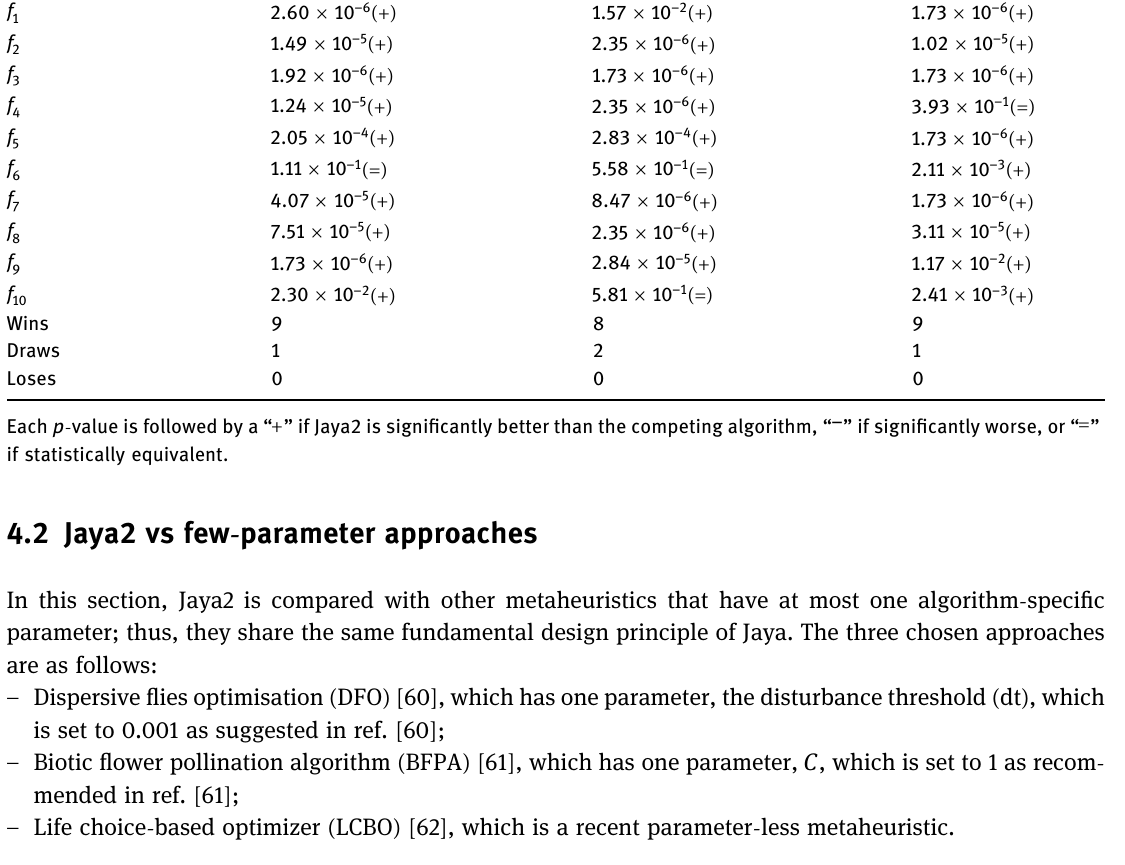
Table 19: The CEC 2020 ( = D 10 ) statistical analysis showing the Wilcoxon test p - value